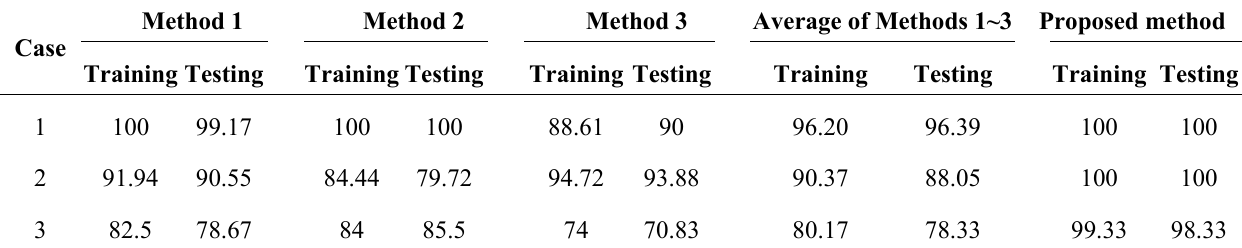
Table 2. Detection accuracies of Methods 1~3 and the proposed